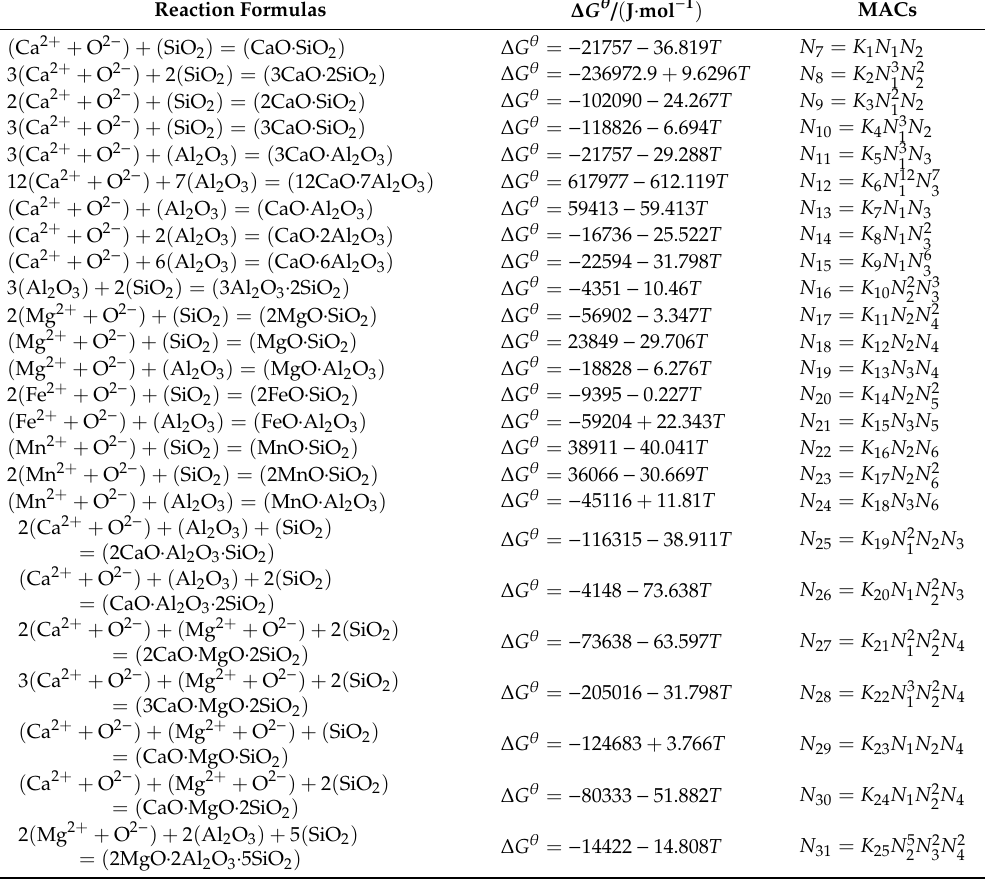
Table 5. Reaction formulas, Gibbs free energies, and mass action–concentrations (MACs) [56,59–64]. Reaction